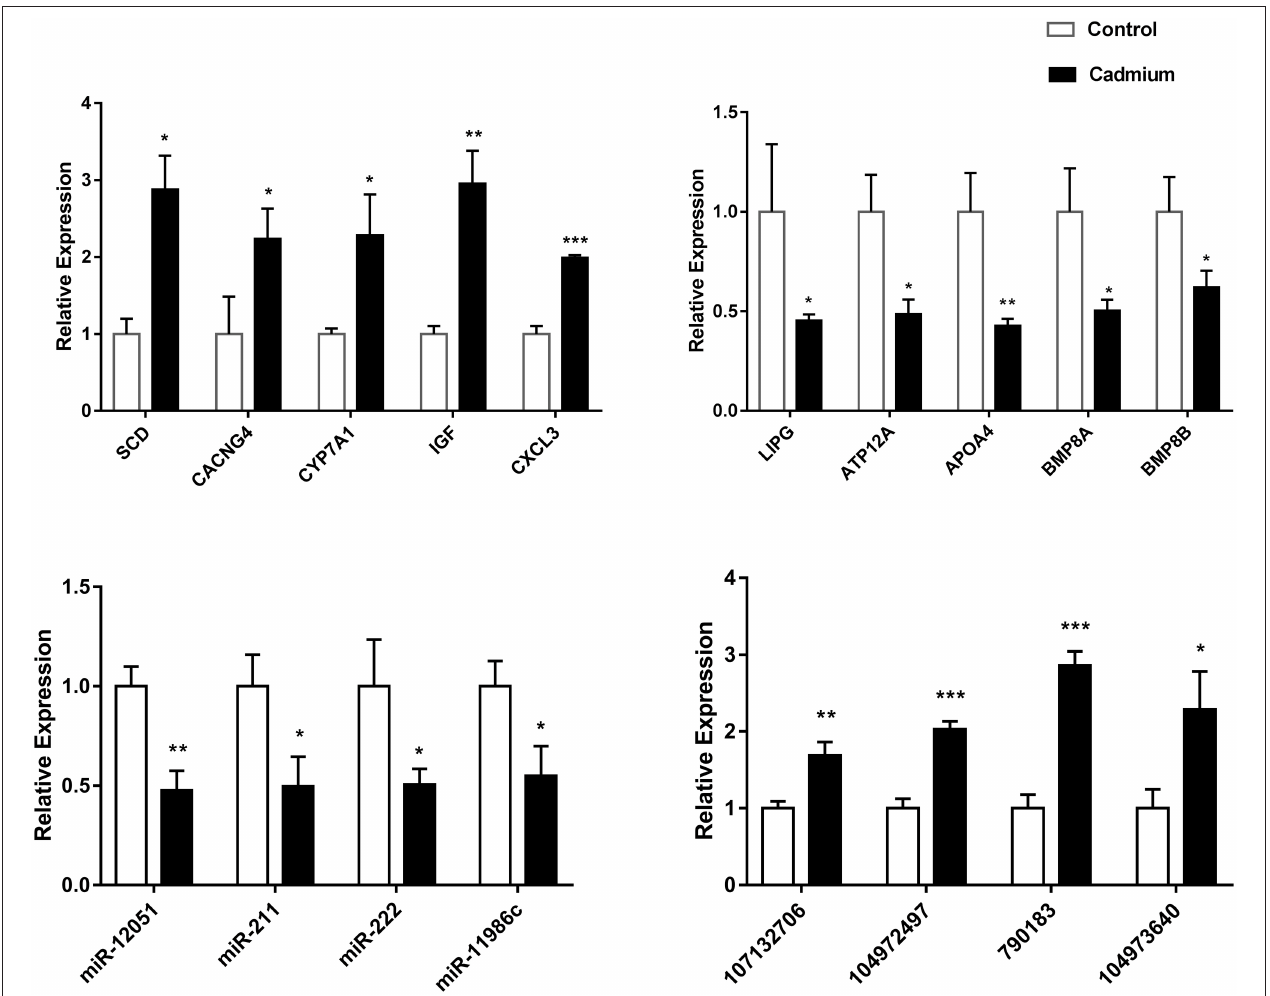
FIGURE 8 | The relative expression of DEGs. The relative expression of the DEGmRNAs (ApoA4, SCD, CYP7A1, CXCL3, LIPG, IGF1, ATP12A, CACNG4, BMP8A, and BMP8B), DEmiRNAs (bta-miR-12051, bta-miR-211, bta-miR-222, and bta-miR-11986c), and DElncRNAs (107132706, 104972497, 790183, and 104973640). Data ( n = 3) are expressed as the mean ± SEM. For the cadmium-treated group compared with control group: * p < 0.05, ** p < 0.01, *** p <